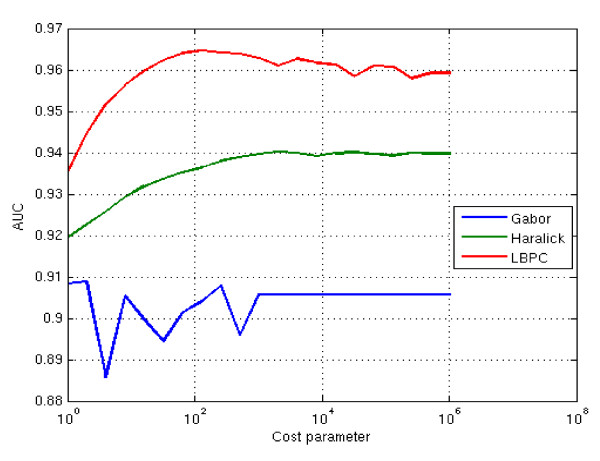
Performance results for LBP/C, Haralick and Gabor texture descriptors on the validation set (colorectal cancer images; n = 576). A linear classifier was optimized for each of the descriptors by computing the accuracy, AUC (area under the ROC curve) over a set of C values (Cost parameter) growing in exponential sequence C = 20,..., 220. The AUC was computed on block level. The selected C values based on the validation tests were: LBP/C; C = 300, Haralick features; C = 2048, and Gabor filters; C = 2